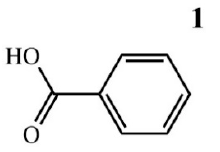
Figure 1. Chemical structure of benzoic acid: ( 1 ).